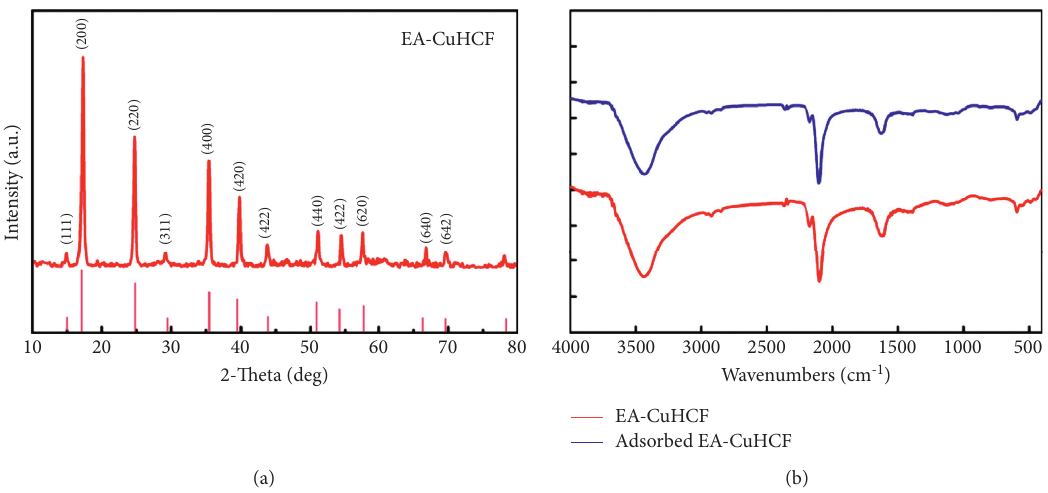
Figure 4: X-ray diffraction patterns of EA-CuHCF (a) and FTIR spectra of EA-CuHCF before and after adsorption (b).